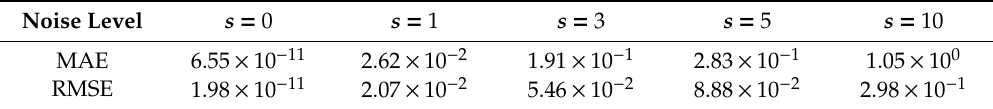
Table 2. Error of the proposed approach for case